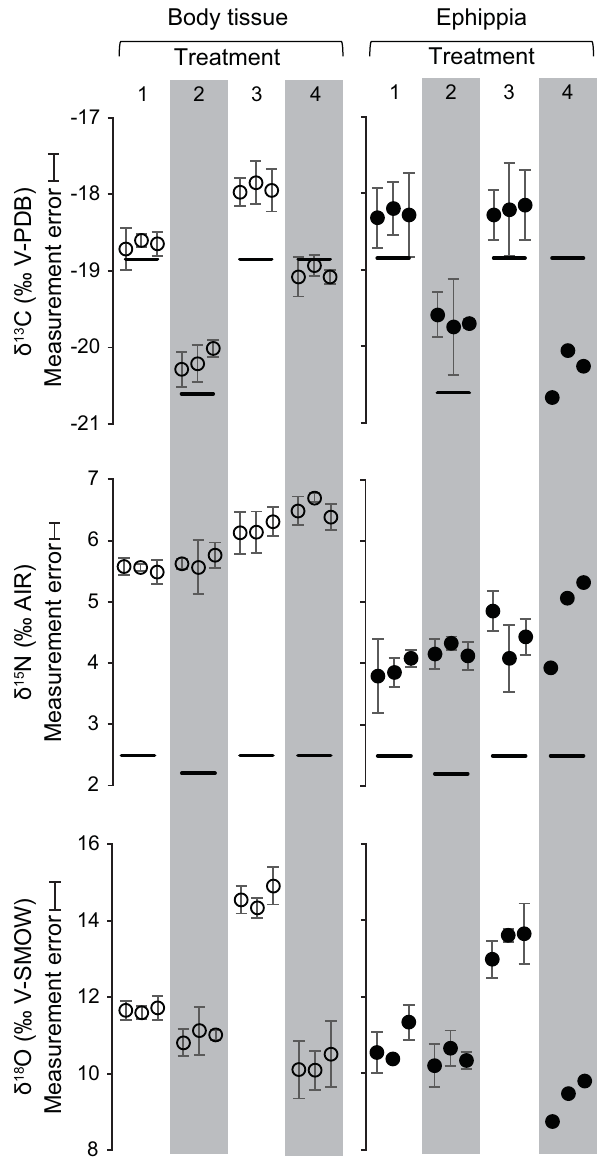
Figure 3. δ 13 C, δ 15 N and δ 18 O values of Daphnia body tissue (left, open circles) and ephippia (right, closed circles) for Treatment 1 (control), 2 ( 13 C-depleted algae), 3 ( 18 O-enriched water) and 4 (el- evated temperature). Each data point represents one of the treatment replicate groups and consists of three measurements, of which the standard deviation is indicated by the error bars (only one measure- ment per replicate treatment group was available for ephippia in Treatment 4). The black horizontal lines in the δ 13 C and δ 15 N plots represent the average value of the algae used in that treatment.